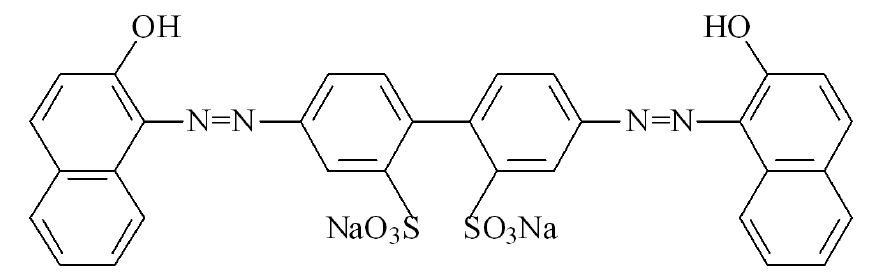
Fig. 2 Chemical structure of Acid Red G azo dye.